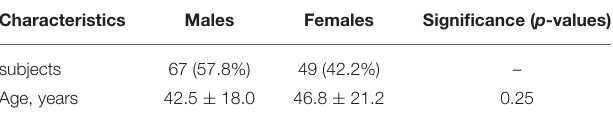
TABLE 1 | Demographic characteristics of the